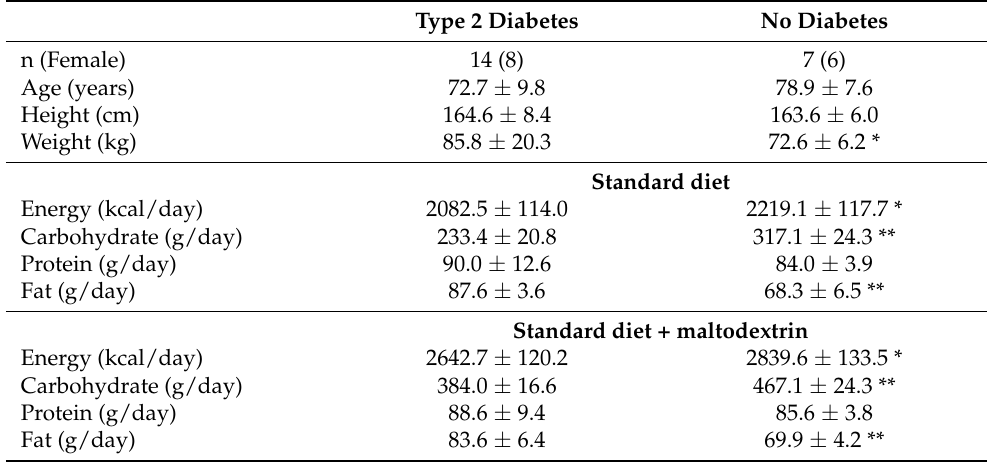
Table 1. Study groups and intake of energy, CHO, protein and fat in study in T2DM patients and patients without diabetes (* p < 0.05, ** p < 0.001).